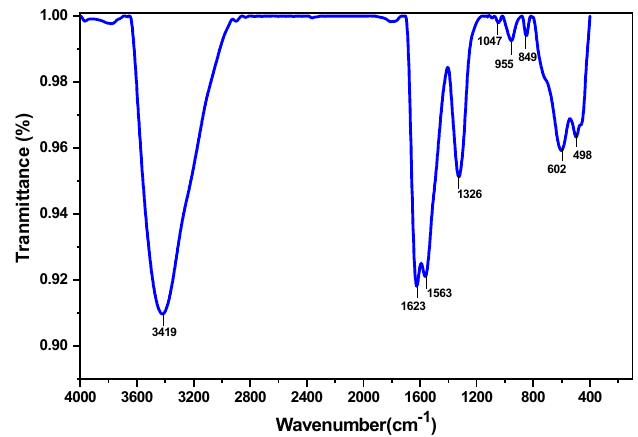
Figure 8. FTIR spectrum of Fe 3 O 4 @mZrO 2 -Re (Re = Y/La/Ce).